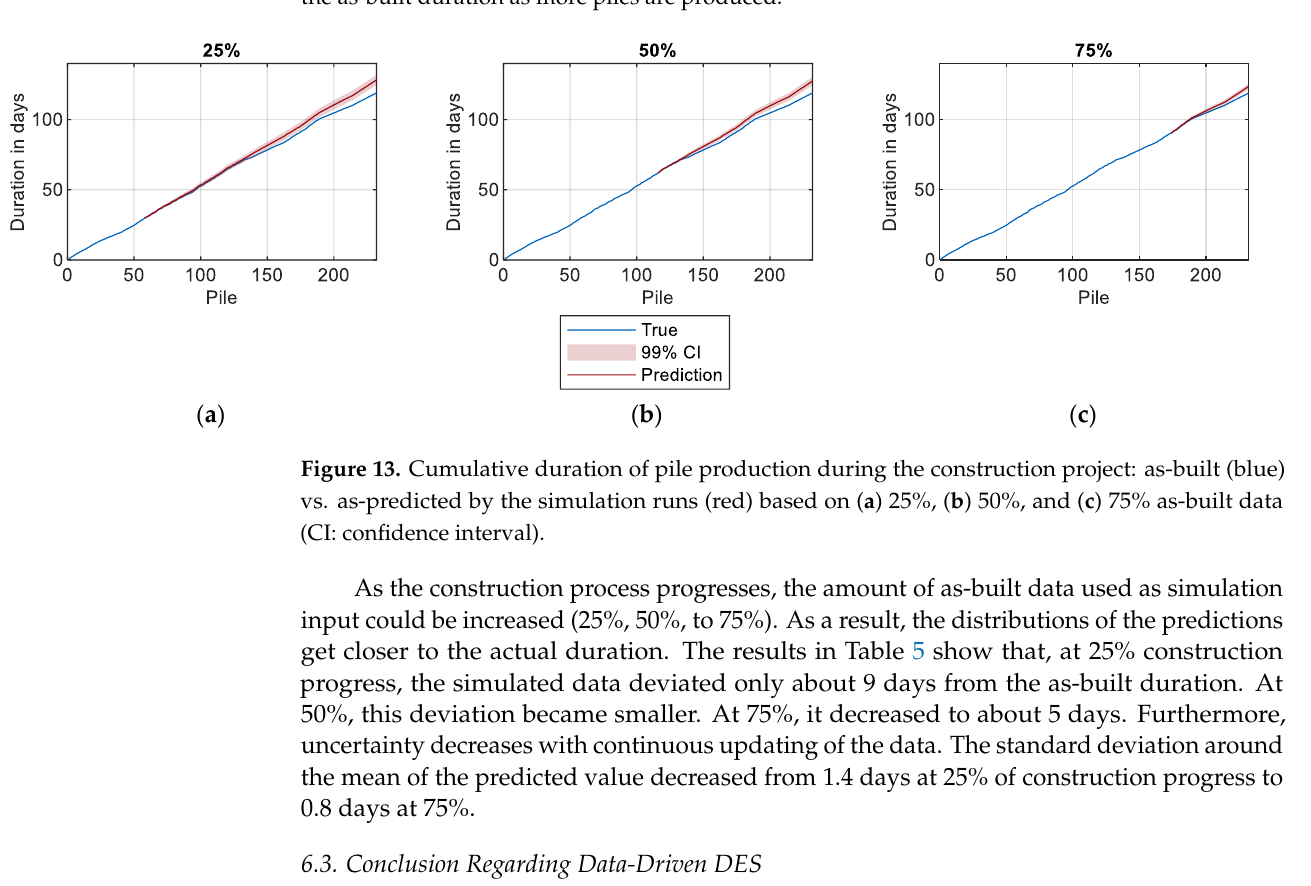
Figure 12. Results from the simulation runs: the forecasts of the construction end time get closer to the as-built duration as more piles are produced.